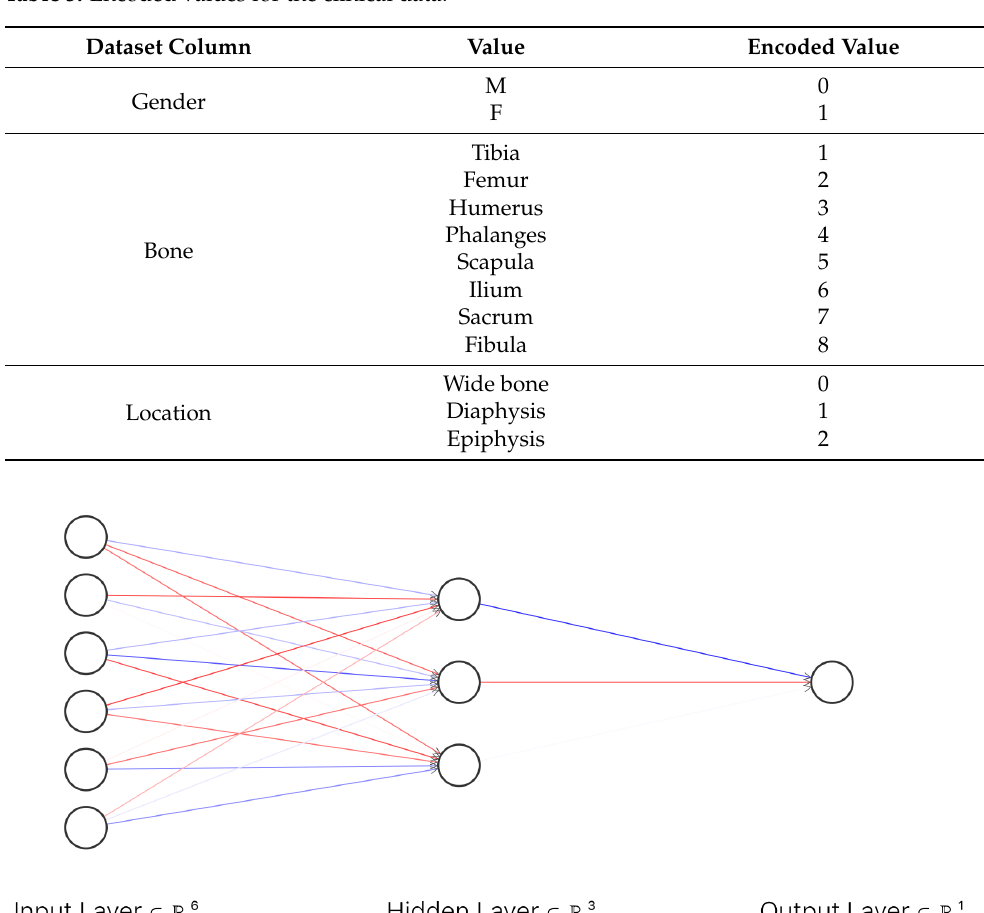
Table 3. Encoded values for the clinical data.